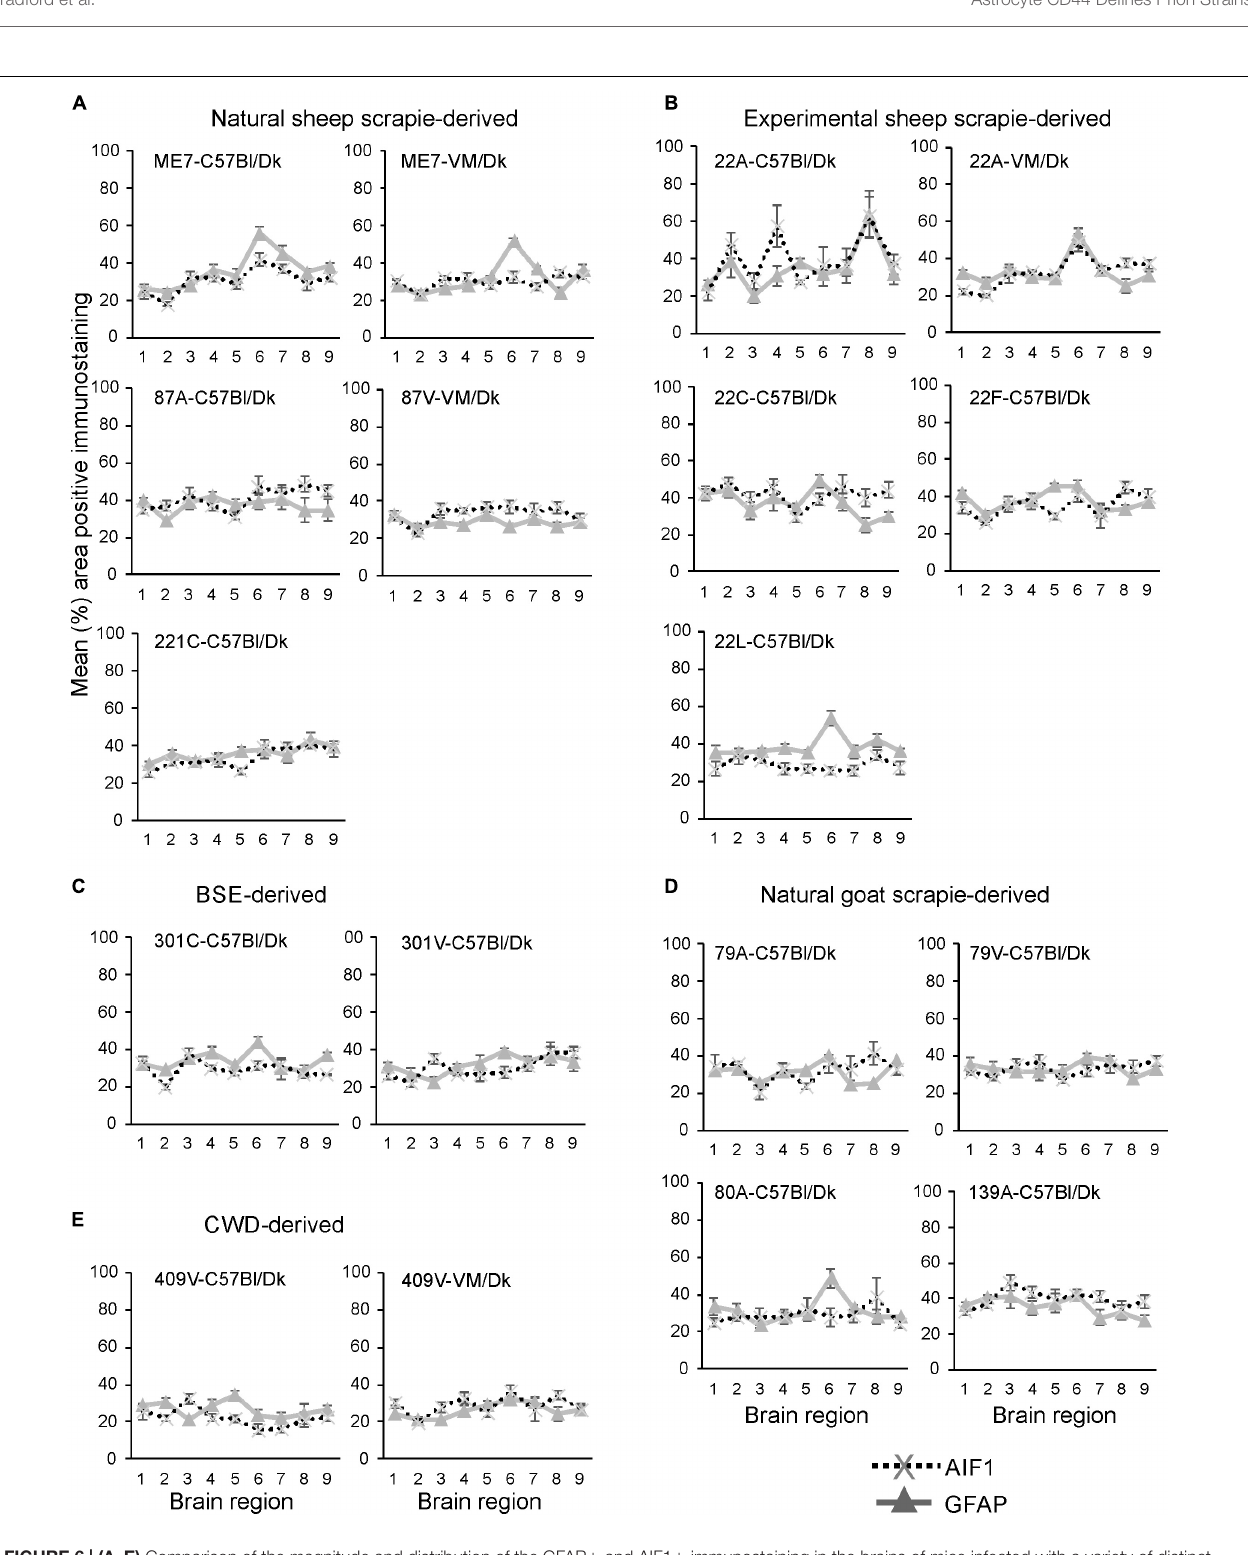
Frontiers in Cellular Neuroscience |